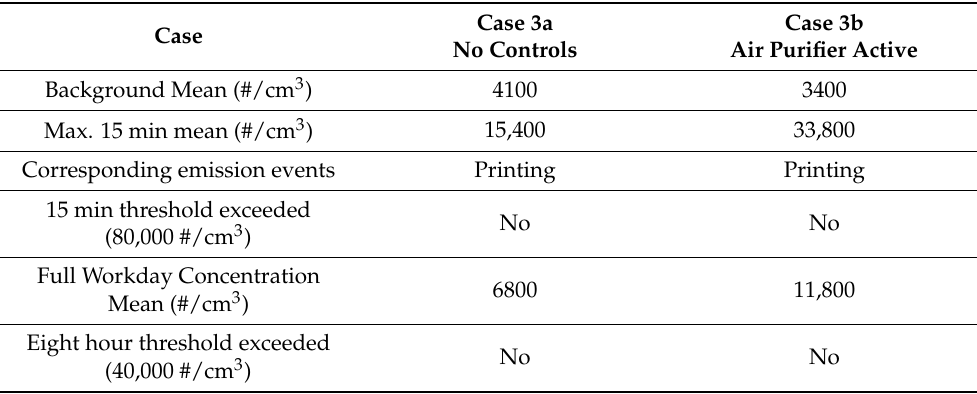
Table 4. Measurement Overview for Case 3—Comparison with exposure